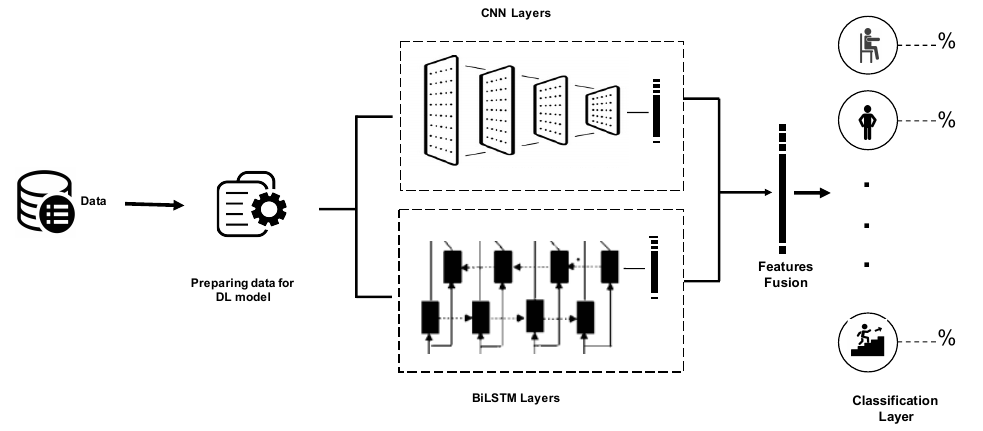
Figure 2. Overall architecture of the proposed